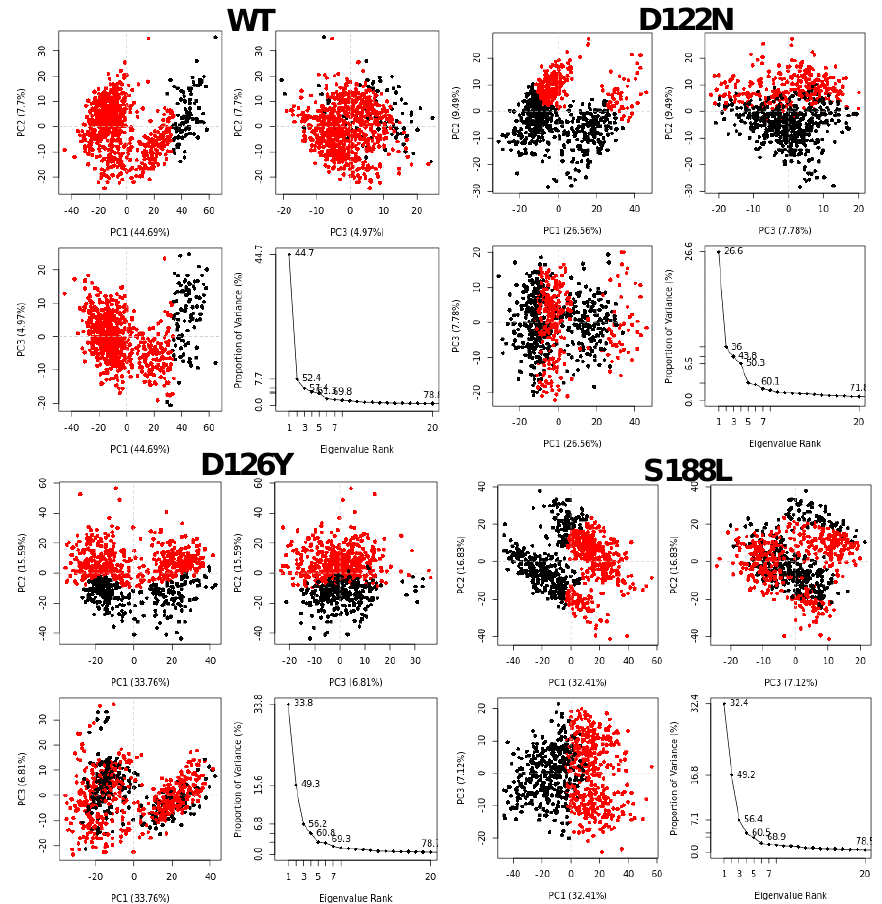
Figure 10. Principal component analysis (PCA) of wild-type and mutant MC4R complexes. The pro-